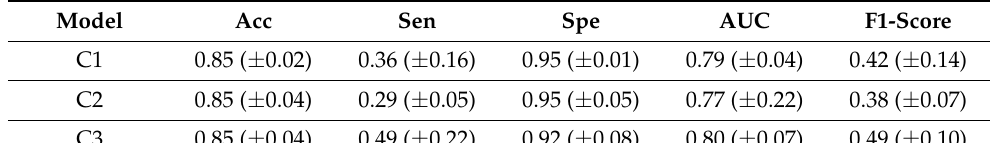
Table 9. Results for the models in K-fold CV for the leave-one-out test set with the respective mean and standard deviation for the 5 folds of each model for the private dataset.